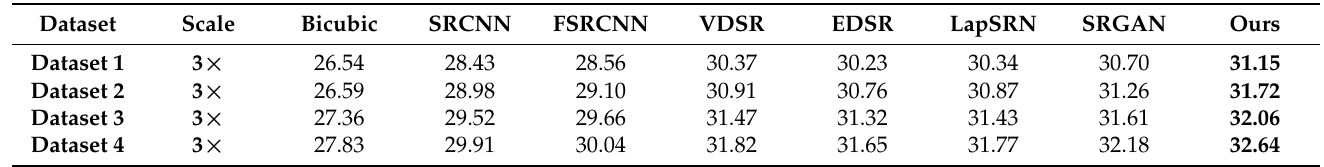
Table 2. Average PSNR on Dataset 1, Dataset 2, Dataset 3, and Dataset 4 with different algorithms.